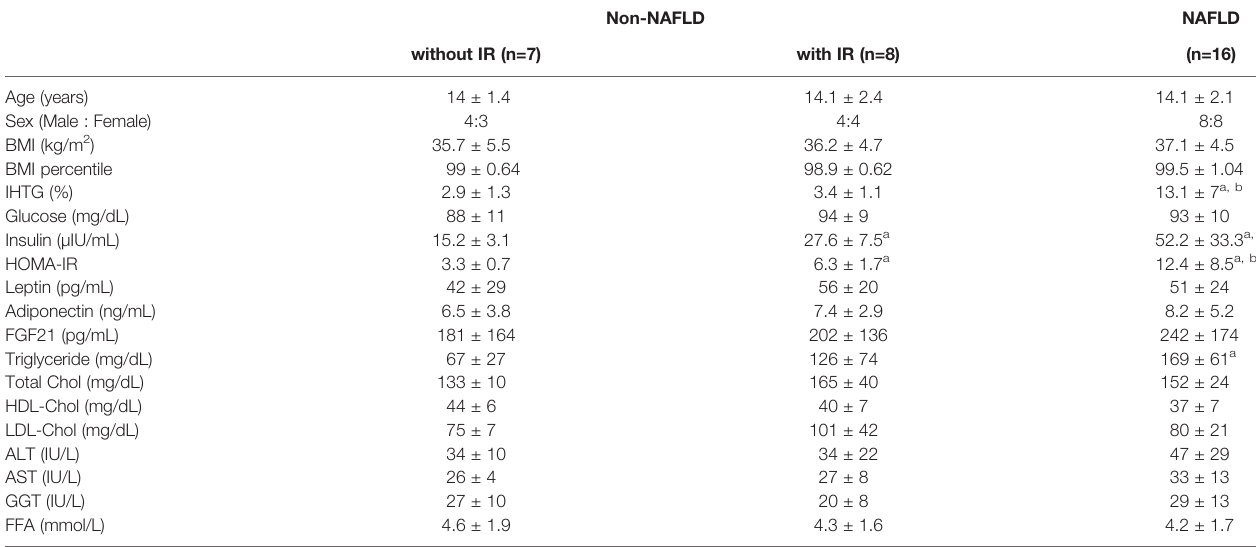
Data are expressed as mean ± standard deviation (SD). Signi fi cant differences between groups were determined by one-way ANOVA followed by post-hoc all-pairwise comparison. Labeled(aorb)meansdifferenceforcomparisonoftwogroupsfollowingtheANOVAanalysis. ALT,alanineaminotransferase;AST,aspartateaminotransferase;FFA,freefattyacids;FGF, fi broblast growth factor; GGT, gamma-glutamyl transferase; IHTG, intrahepatic triglyceride. a p < 0.05 compared with non-NAFLD without IR group; b p < 0.05 compared with non-NAFLD with IR